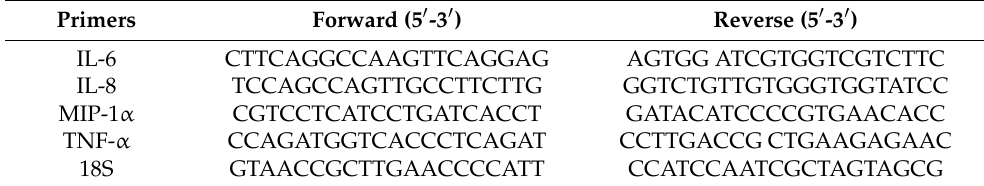
Table 1. Primer sets for real-time